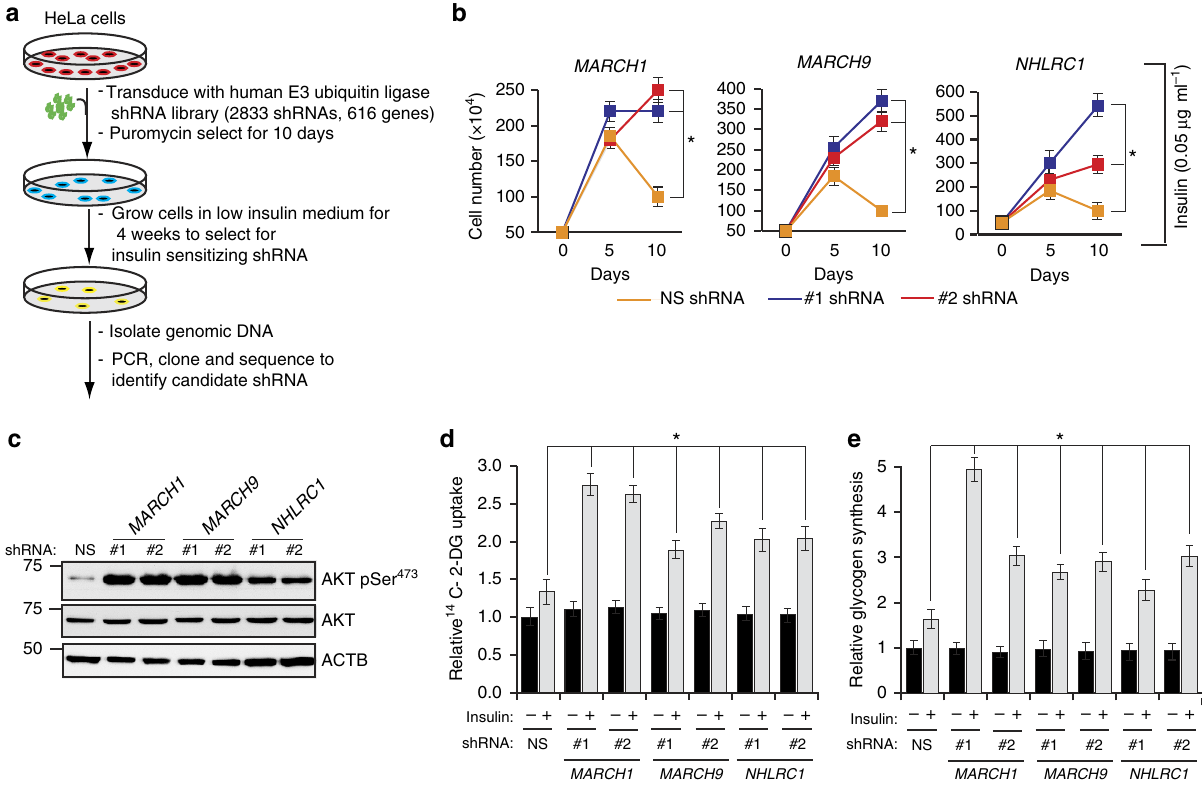
Figure 1 | A large-scale RNAi screen identifies MARCH1 as a repressor of insulin signalling. ( a ) Schematic summary of the RNAi screen. ( b ) Relative cell number ( n ¼ 3), calculated using Trypan blue exclusion, for HeLa cells expressing indicated shRNAs and grown in suboptimal insulin concentration (0.05 m gml (cid:2) 1 ) for the indicated number of days. *compares NS and MARCH1 shRNAs at day 10. ( c ) Immunoblot analysis of AKT Ser 473 phosphorylation in HeLa cells expressing either NS or MARCH1 , MARCH9 or NHLRC1 shRNAs. ( d ) Relative 14 C-2-deoxyglucose uptake ( n ¼ 4) in HeLa cells expressing indicated shRNAs. *compares NS and indicated shRNAs in presence of insulin. ( e ) Relative glycogen synthesis ( n ¼ 3) in HeLa cells expressing indicated shRNAs. *compares NS and indicated shRNAs in presence of insulin. In all panels, data are mean ± s.e.m. and * P o 0.05, comparisons by t -test. NS,